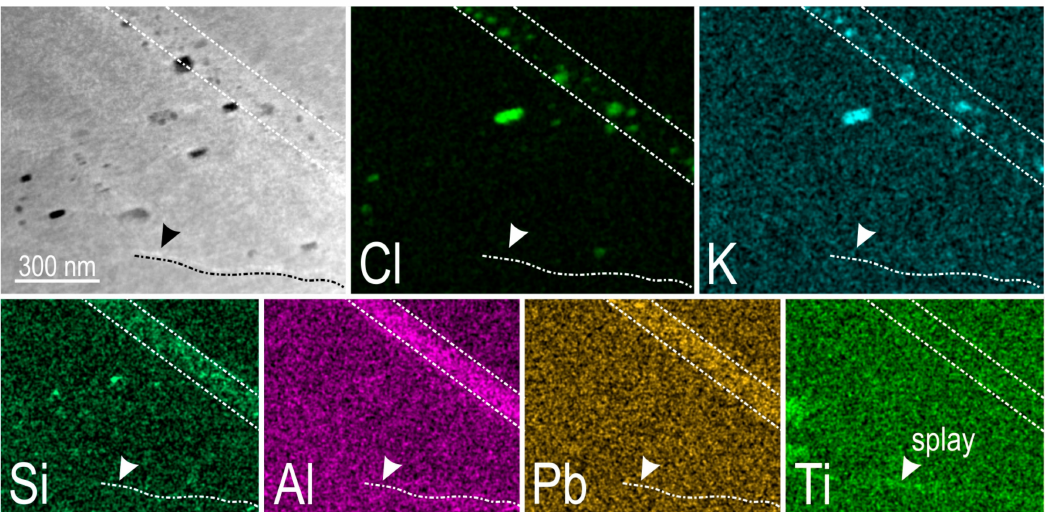
Figure 13. HAADF STEM image (left) and STEM EDX maps of the trail at the lower part of foil #4 (part of area shown in Figure 11). Note Cl and K show high concentrations either within the trail or along splays, whereas other elements, including Pb, are evenly distributed across the width of the trail. In contrast, Ti is present outside of the trail.